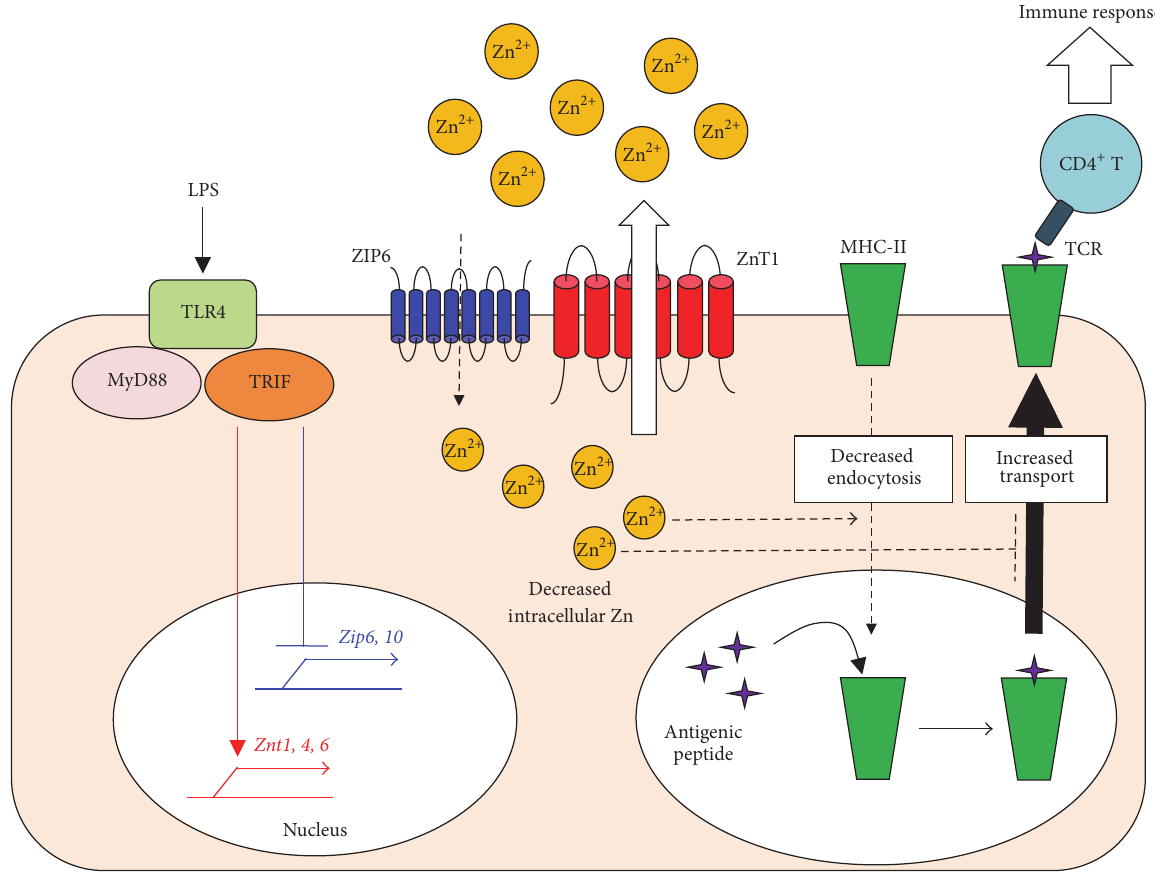
Figure 4: A decrease in intracellular-free Zn is critical for LPS-mediated CD4 + T-cell activation by DCs. LPS, a TLR4 ligand, induces DC activation, which initiates a maturation signal mediated by MyD88 and TRIF. TRIF-mediated signaling reduces the expression of ZIPs (blue) and increases that of ZnTs (red), resulting in a net decrease in the intracellular-free Zn level in DCs. This reduction of intracellular-free Zn is critical for the antigen presentation via MHC-II molecules and the subsequent activation of antigen-specific CD4 + T cells.